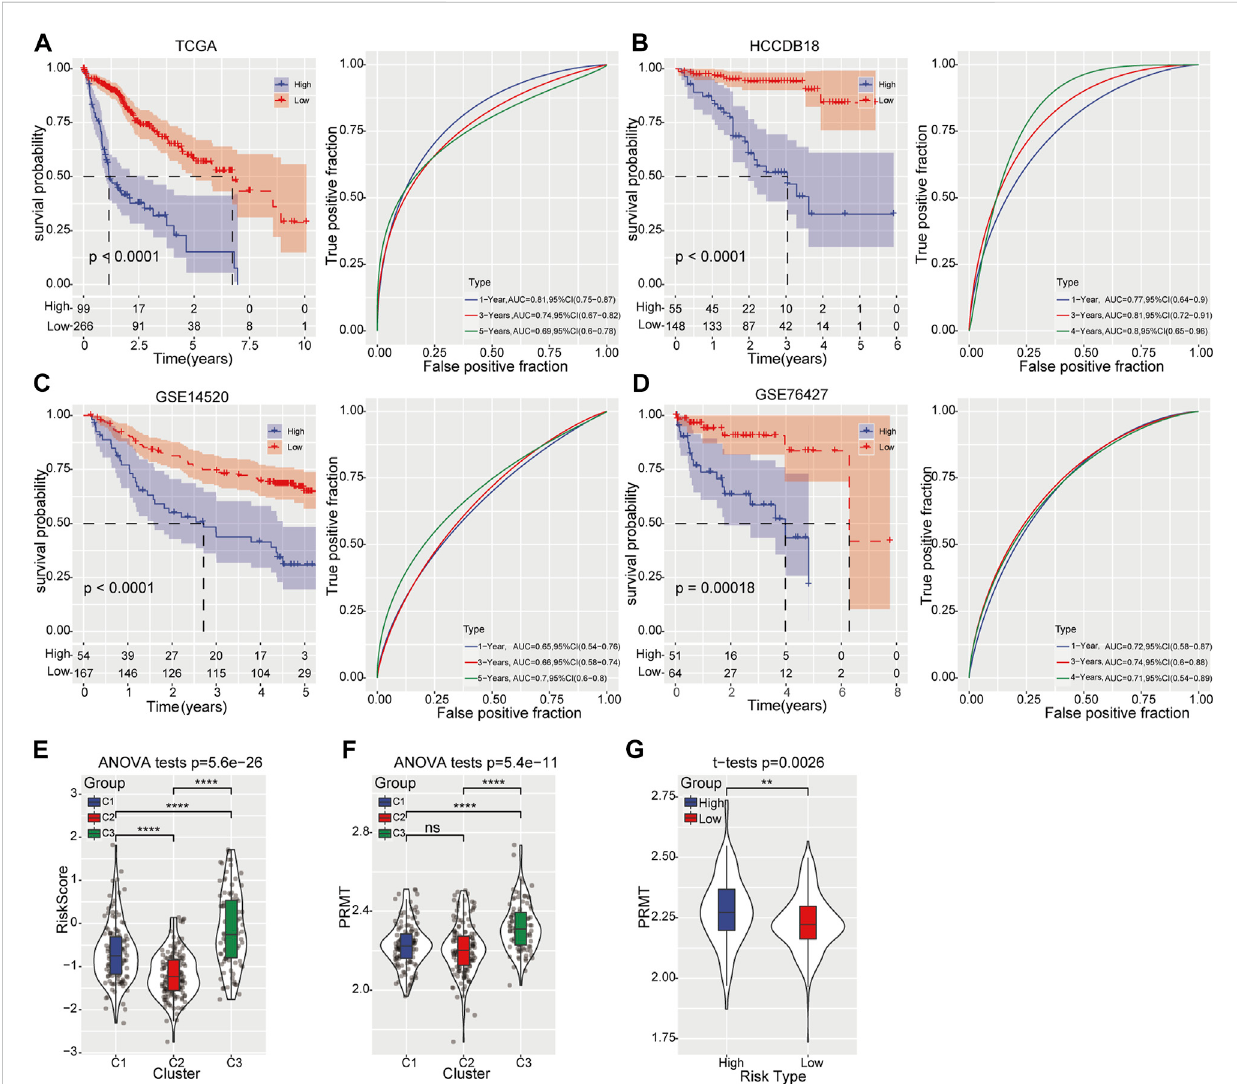
FIGURE 3 Prognosticriskmodelconstructionandvalidation (A) Kaplan-Meiercurve(left)displaystheOSofHCCpatientspredictedbyprognosticriskmodelin TCGA-LIHCtrainingcohort.ThepredictiveperformancewasdeterminedbyROCcurve(right). (B – D) Kaplan-Meiercurve(left)representstheOSofHCC patients validated in HCCDB18, GSE14520, and GSE76427 cohort respectively. The predictive ability was determined by ROC curve (right). (E) The distributionofriskscoreamongthethreemolecularsubtypes. (F) TheexpressionofPRMTsamongthreemolecularsubtypes. (G) ThelevelofPRMTs in the high- and low-risk